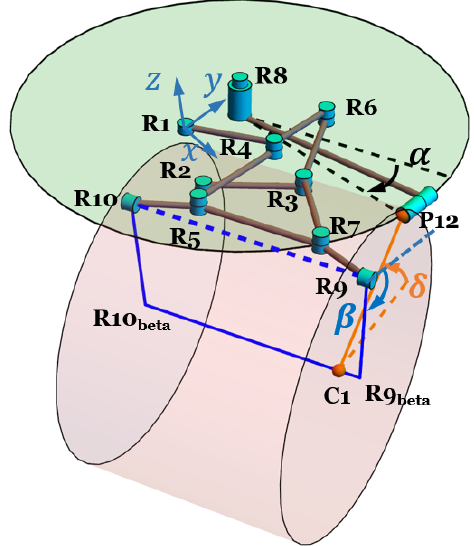
Figure 3. The schematic for the inverse kinematic